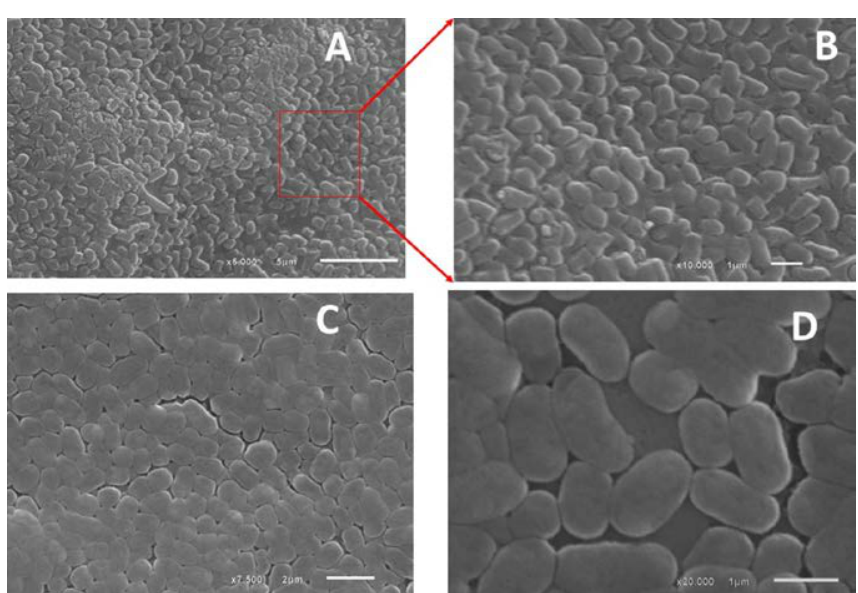
Fig. 4. Biofilm formation in Klebsiella pneumoniae (a) Planktonic cell (b) enlargement of red box view of planktonic cell (c) in presence of Pluronic F127 (d) in presence of